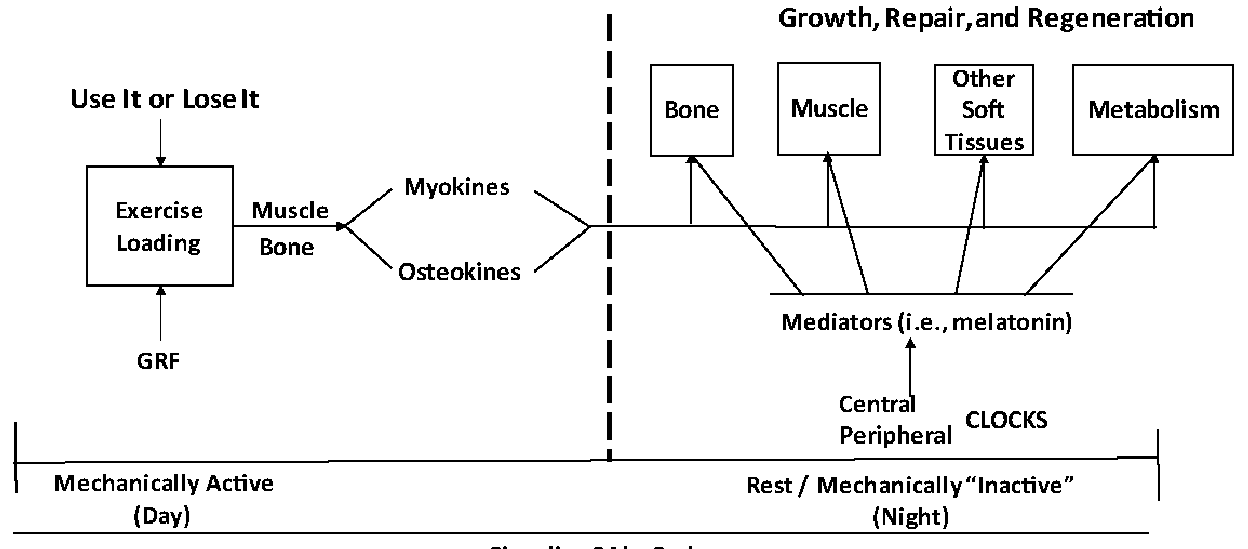
Figure 3. Schematic of the potential effects of loading on the MSK system and how this might require integration of exercise/loading-associated mediators (myokines and osteokines) with mediators following a circadian pattern.